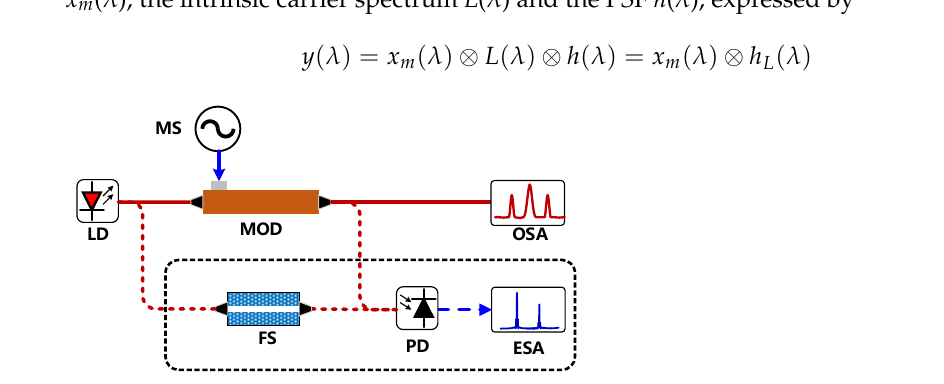
Figure 3. Schematic setup for measuring electro-optic modulators. LD, laser diode. MS, microwave source. OSA, optical spectrum analyzer. MOD, electro-optic modulator. FS, frequency shifter. PD, photodetector. ESA, electrical spectrum analyzer.